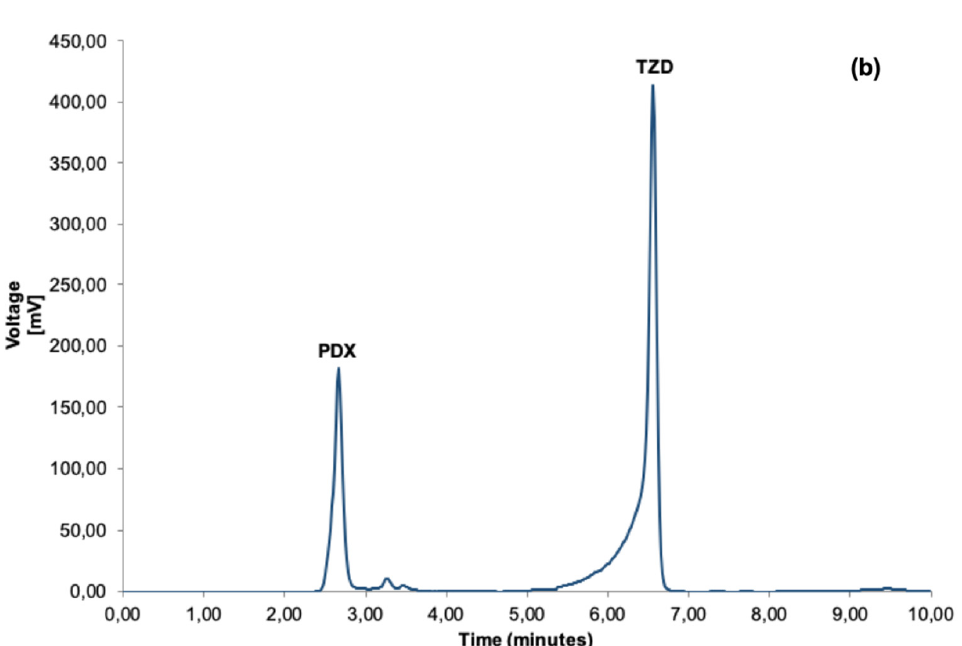
Figure 3. Overlay of chromatograms obtained with ( a ) mobile phase, pH 1.2, pH 4.5, and pH 6.8 buffered media and distilled water; ( b ) PDX and TZD dissolved in the described diluent.